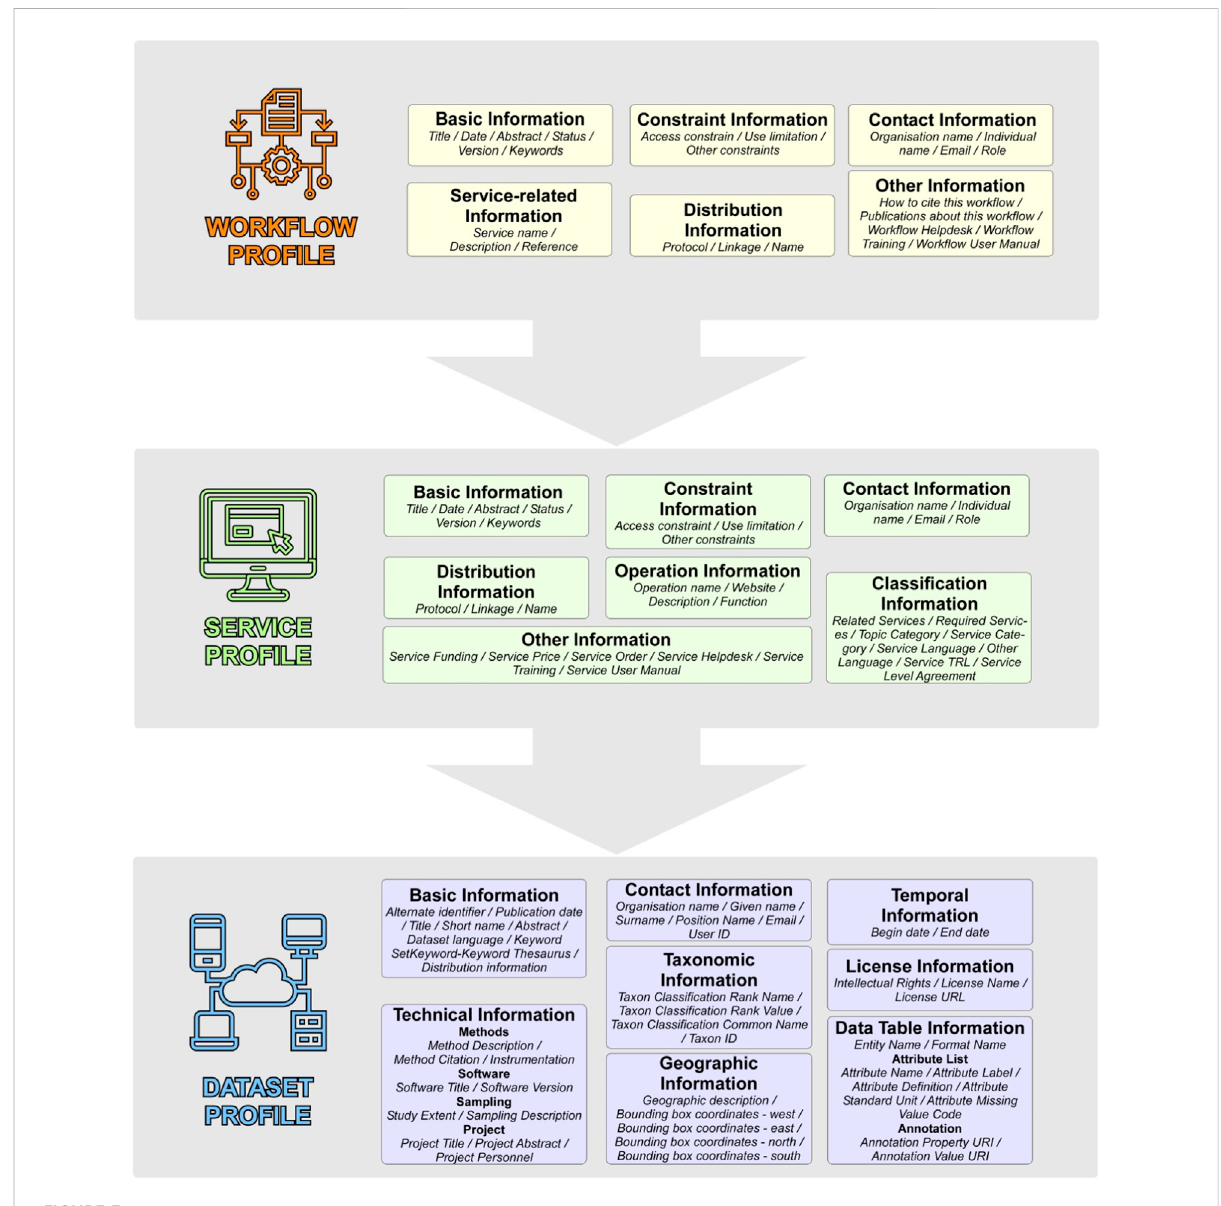
FIGURE 3 LifeWatch ERICmetadatapro fi lefor work fl ows(yellow),services(green),anddatasets(blue). Theasterisks (*)indicatethemandatoryattributes. A complete description of the LifeWatch ERIC Application pro fi les is available in Vaira et al.